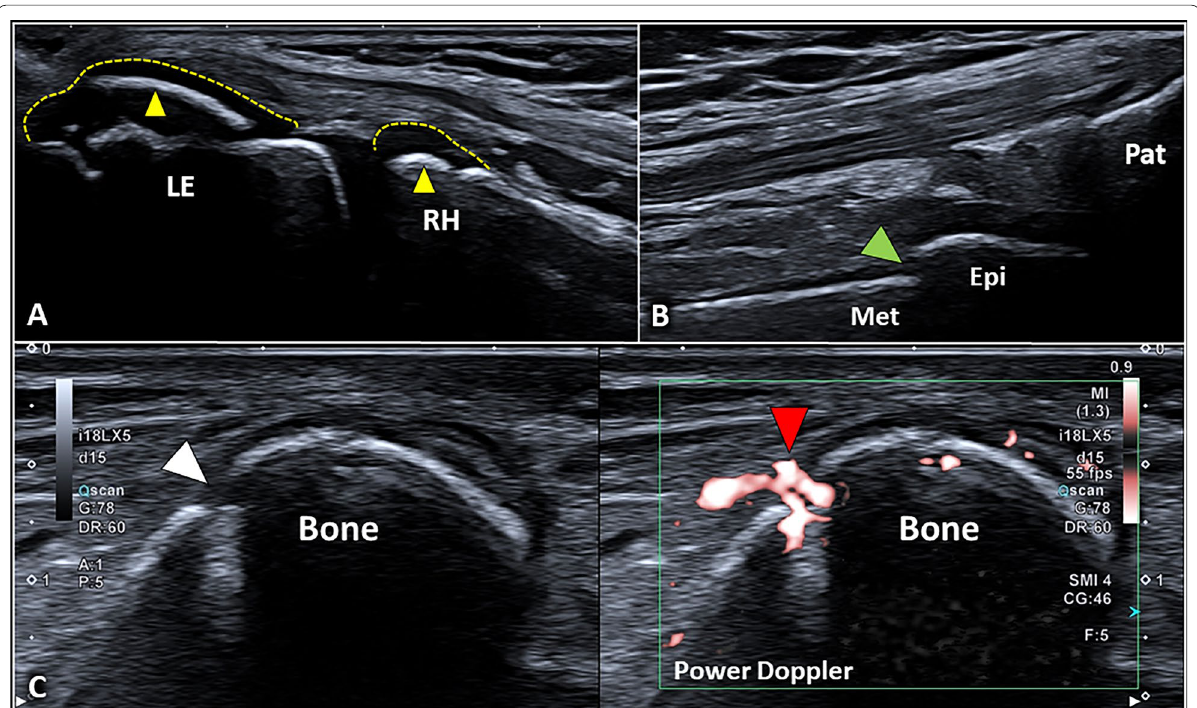
Fig. 2 Normal sonographic findings of the bone tissue. A longitudinal view of the lateral elbow in a young volunteer clearly shows the cartilaginous epiphysis ( yellow dotted lines ) of the radial head ( RH ) and lateral epicondyle ( LE ); of note, the hyperechoic lines ( yellow arrowheads ) within the hyaline cartilage are the epiphyseal ossification centers ( A ). Likewise, a longitudinal scan of the suprapatellar region in the knee shows the physis ( green arrowhead ) in between the metaphysis ( Met ) and epiphysis ( Epi ) of the distal femur in a child ( B ). Importantly, focal interruption of the (hyperechoic) cortical bone can be related to the presence of nutritional foramina ( white arrowhead ) crossed by feeding vessels ( red arrowhead ) ( C ). Pat